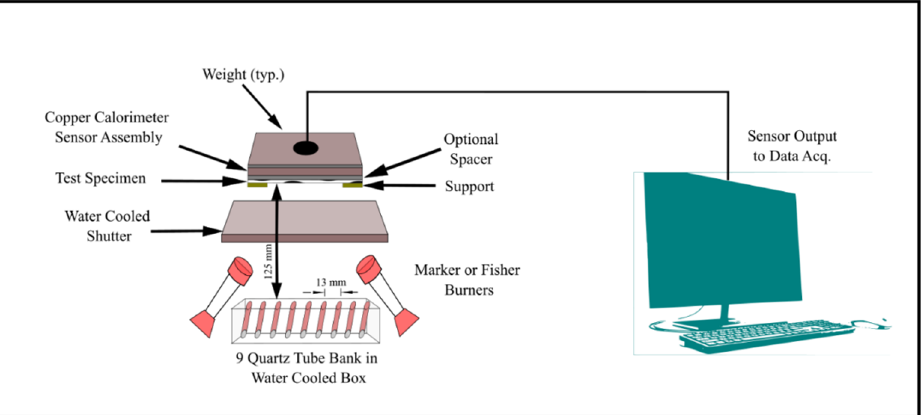
Figure 2. Thermal protective performance tester. Heat transfer performance (HTP) value was calculated as cal/cm 2 = t Intersect second × calibrated burner heat flux value, cal/cm 2